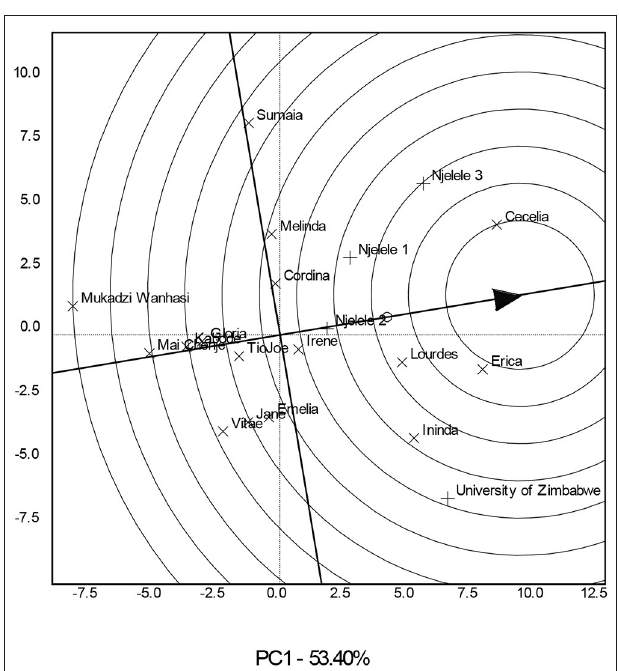
FIGURE 1 | A variety comparison biplot showing the best sweetpotato varieties based on stability and mean performance across four